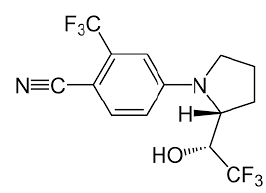
Figure 24. Chemical structure of ligandrol. Formula: C 14 H 12 F 6 N 2 O.